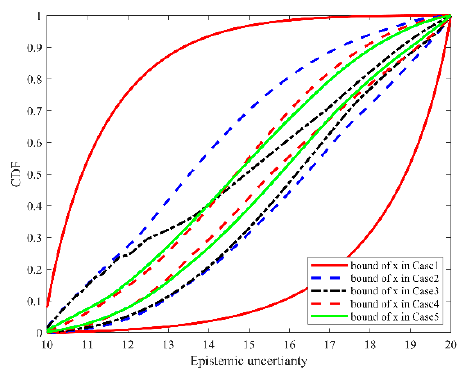
Figure 7. Cumulative probability density function comparison of epistemic uncertainties with different types of uncertainty information. Table 2. Four statistical moments of epistemic uncertainties in example 1.